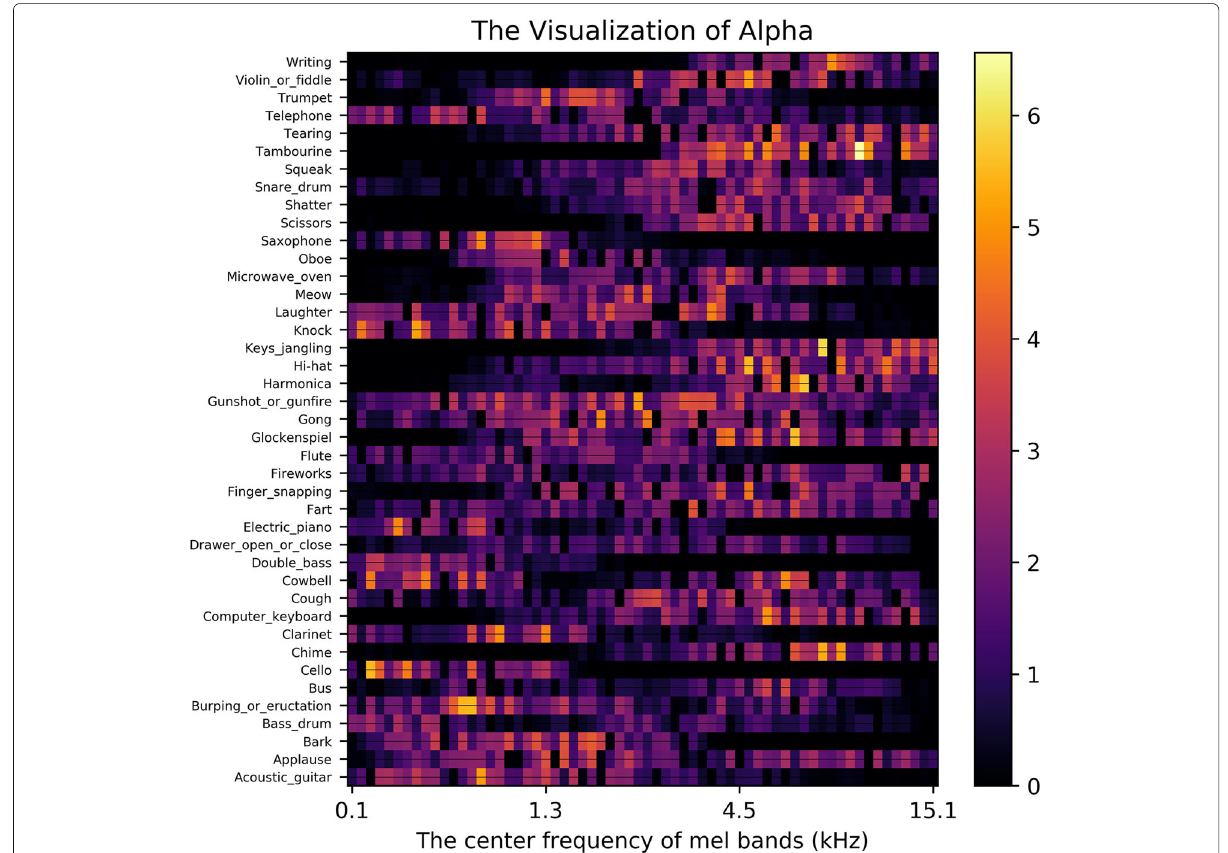
Fig. 4 Learned α k ( f ) parameters for each event class